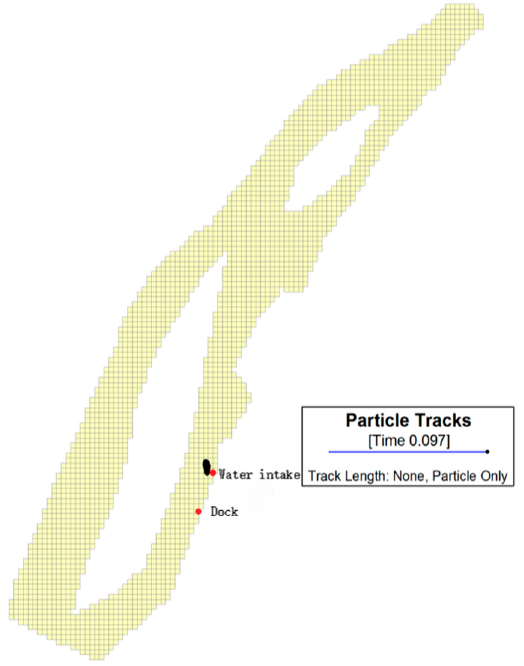
Figure 4. Influence range of oil slick drift in an oil spill accident (when the oil slick reaches the water intake).